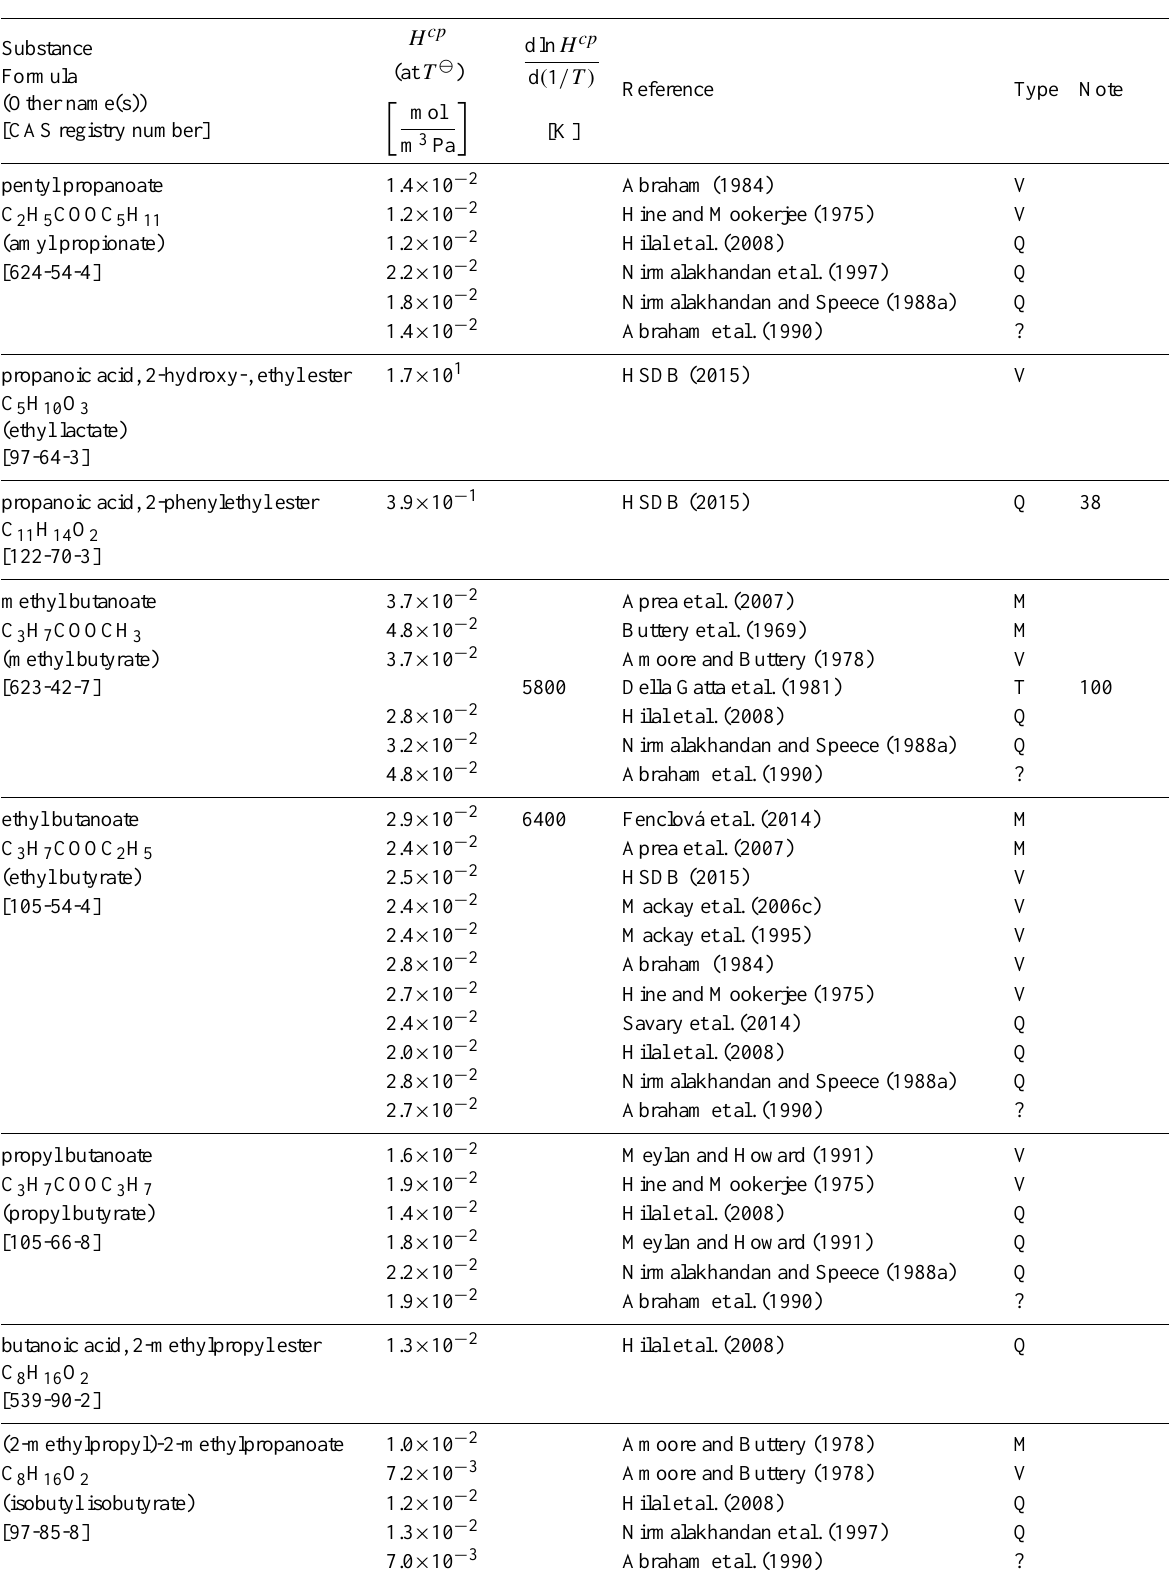
Table 6: Henry’s law constants for water as solvent